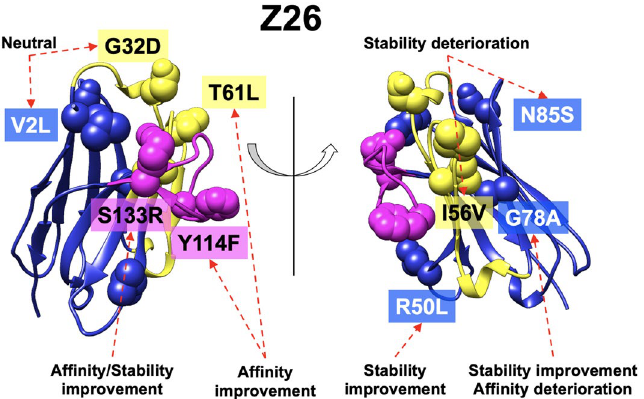
Figure 5. Correlations between the location and effect of the mutations. Residues that differ between Z18 and Z26 are shown as spheres. CDR-H1 and H2 are colored in yellow whereas CDR-H3 are in